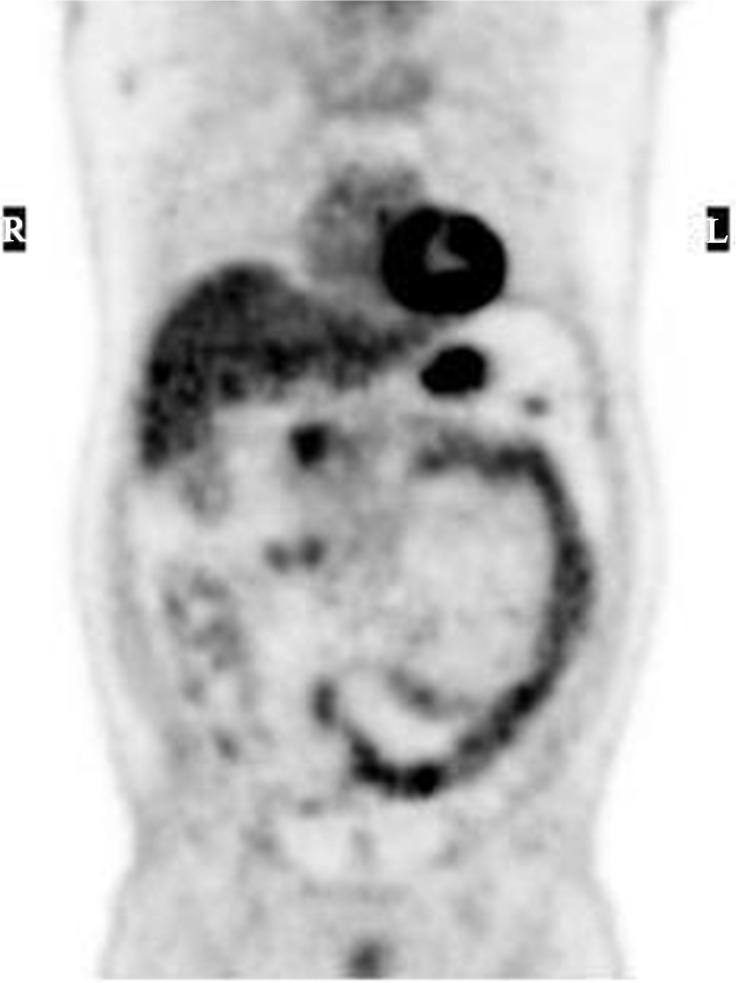
Image clearly showing 18FDG the in the descending colon (DC) and the sigmoid and rectum (S&R).The outline of the caecum and ascending colon (C&AC) can also be clearly seen. Note that only the left hand end (right hand end on the image) of the transverse colon (TC) is clearly visible. The transverse colon (TC) is approximately horizontal and extends from just below the lowest point in the liver (which can be clearly seen) to the top of the descending colon.